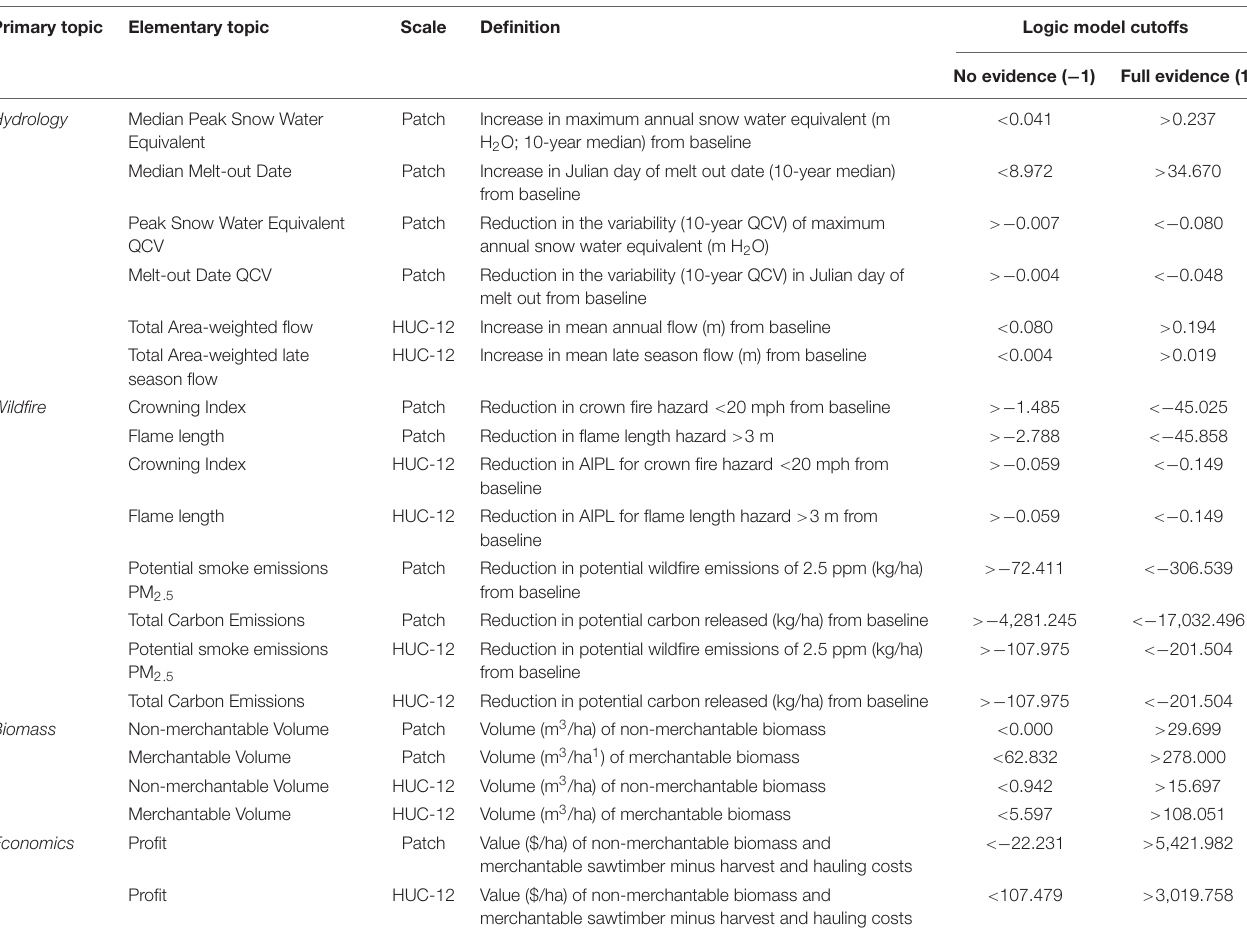
TABLE 1 | Evaluation metrics used in the decision support tool